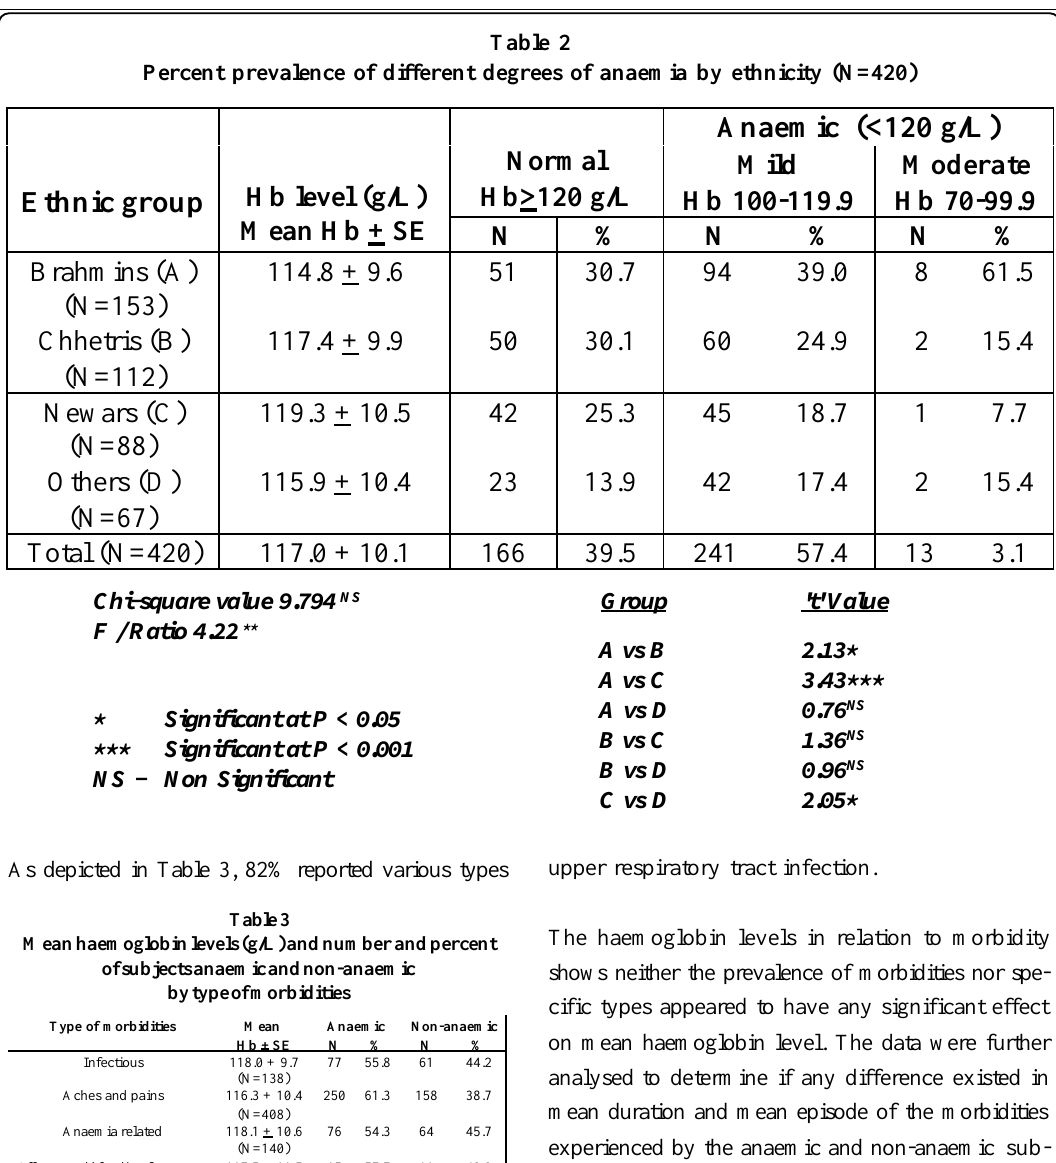
Percent prevalence of different degrees of anaemia by ethnicity